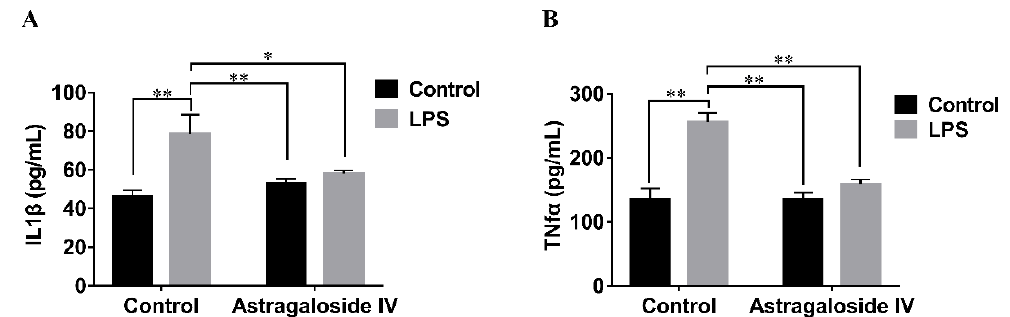
Figure 6. Effects of Astragaloside IV on the production of IL-1 β and TNF- α in uteri. The levels of IL-1 β and TNF- α were detected by ELISA assay. Two-way analysis of variance was performed with a Bonferroni post hoc multiple comparison test. Data are shown as mean ± SD. n = 6. * p < 0.05; ** p < 0.01.